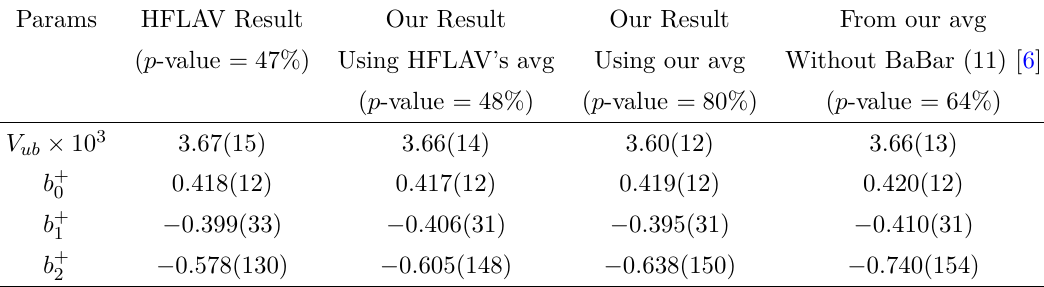
Table 2 . Comparison between our and HFLAV’s fit to the average q 2 spectrum along with the inputs from lattice and LCSR ( q 2 = 0 ), see the text for details.